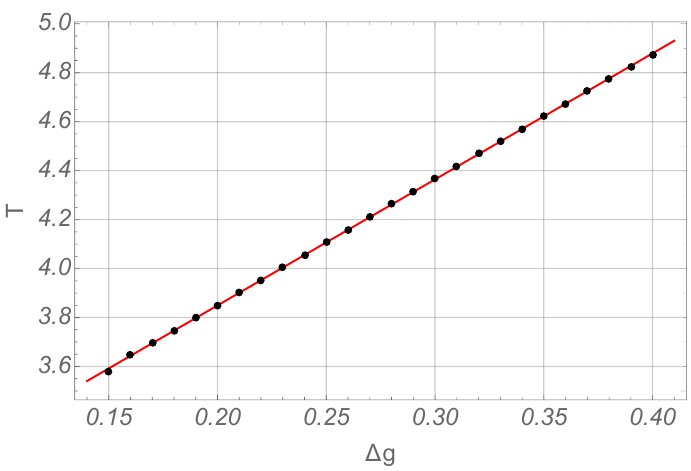
Figure 3: The effective temperature fits linearly with the quench